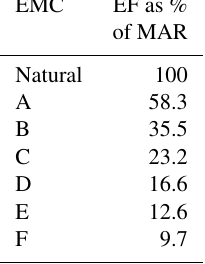
Table 1. Mean annual EF requirements (yields) under each Envi- ronmental Management Class (EMC).